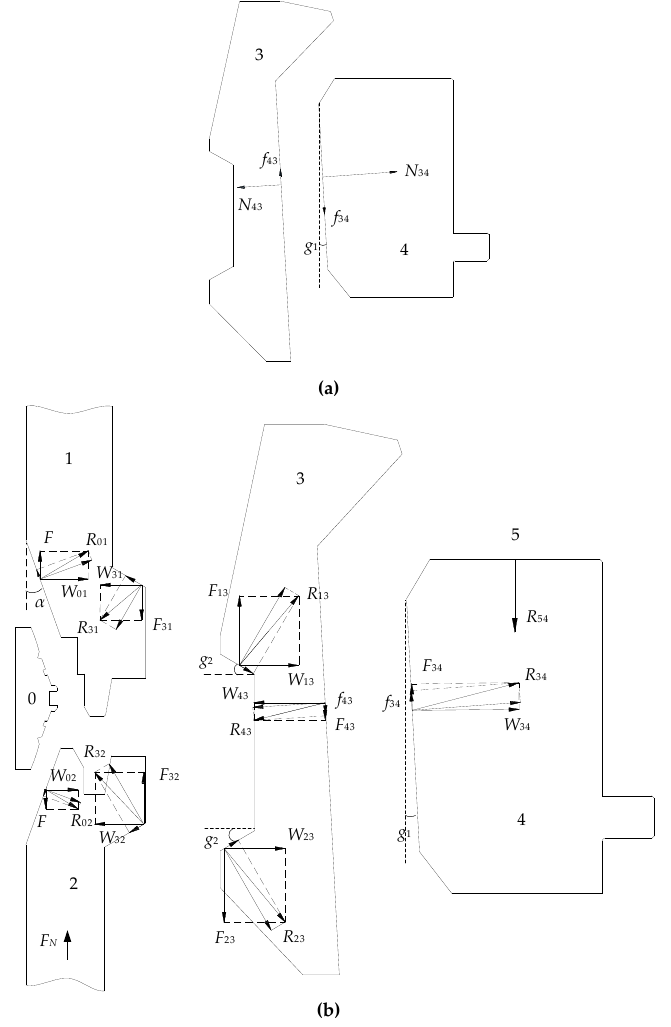
Figure 5. Schematic of force transmission diagram of the subsea collet connector sealing structure. 0-sealing gasket, 1-upper hub, 2-base hub, 3-finger, 4-press ring, 5-loading hydraulic cylinder. ( a ) The force of the press ring in operating mode; ( b ) The force of the preloading mode.